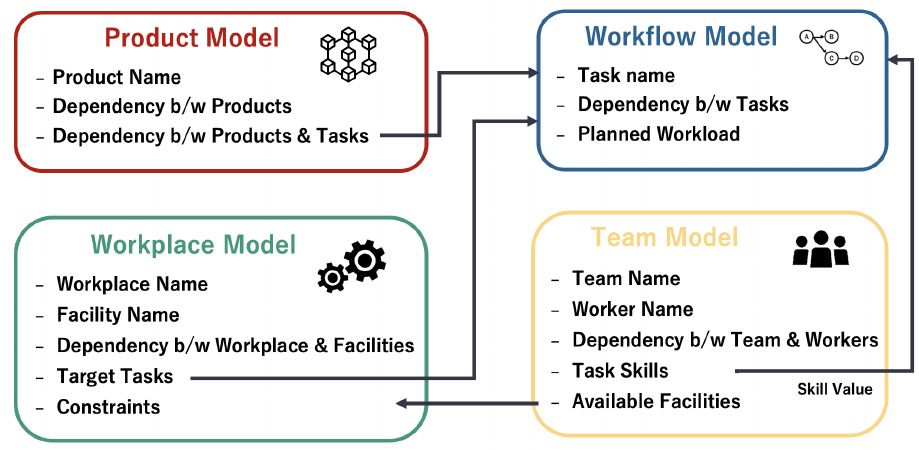
Figure 5. Proposed System Models and These